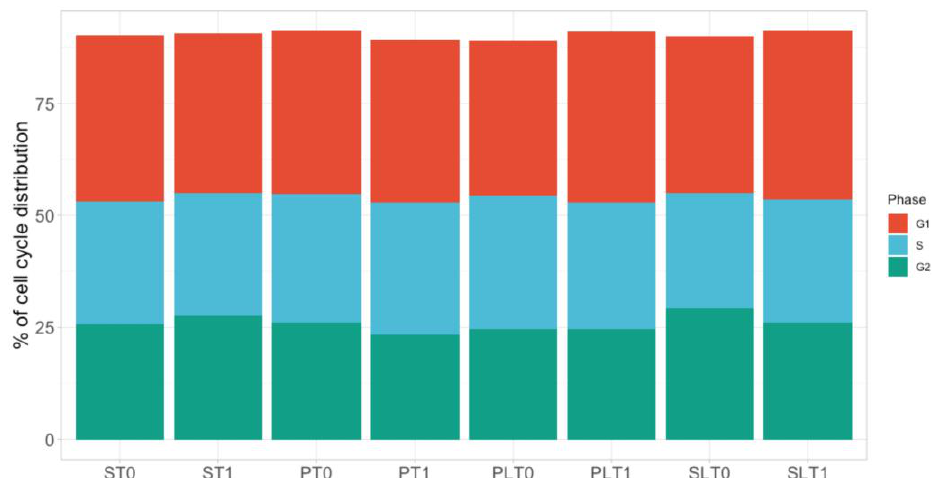
Figure 3. Cell cycle phase evaluation of the HCT-116 cell line in our study groups: TIVA with lidocaine (group PL, before surgery — T0 and after surgery — T1); TIVA (group P, before surgery — T0 and after surgery — T1); sevoflurane with lidocaine (group SL, before surgery — T0 and after surgery — T1); sevoflurane (group S, before surgery — T0 and after surgery — T1).